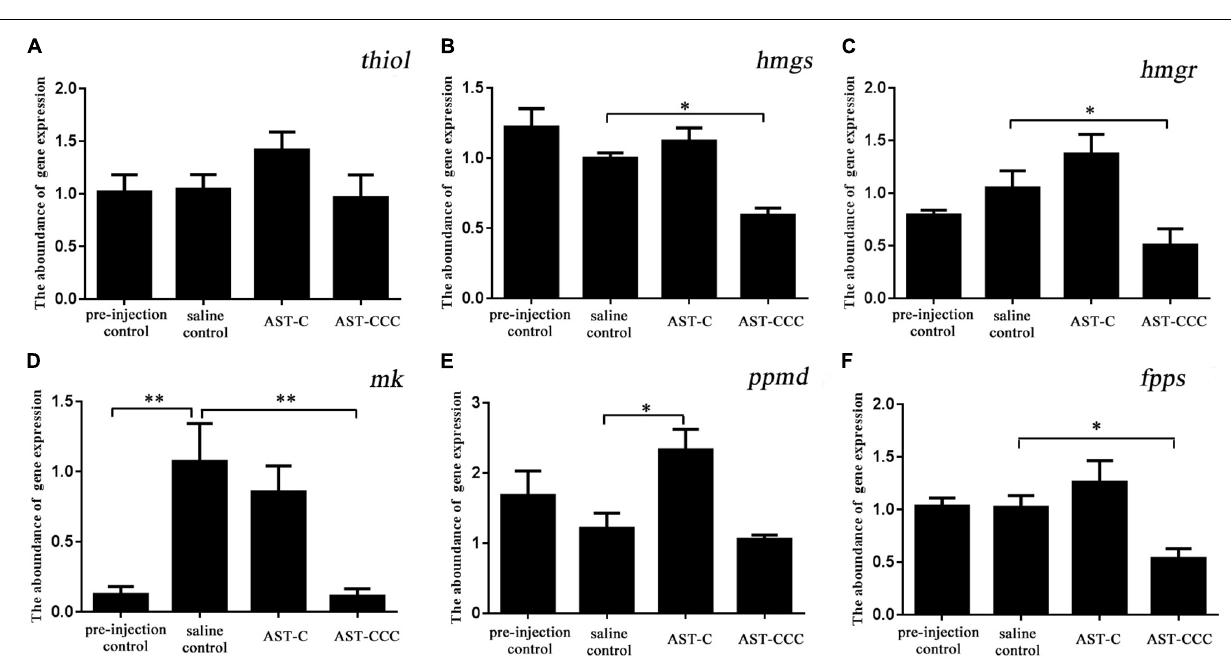
FIGURE 7 | In vivo effects of Scypa AST-C and Scypa AST-CCC peptides on the abundance of MF biosynthetic enzyme genes in the mandibular organ. (A) thiol : acetoacetyl-CoA thiolase ; (B) hmgs : 3-hydroxy-3-methylglutaryl-CoA synthase ; (C) hmgr : 3-hydroxy-3-methylglutaryl-CoA reductase ; (D) mk : mevalonate kinase